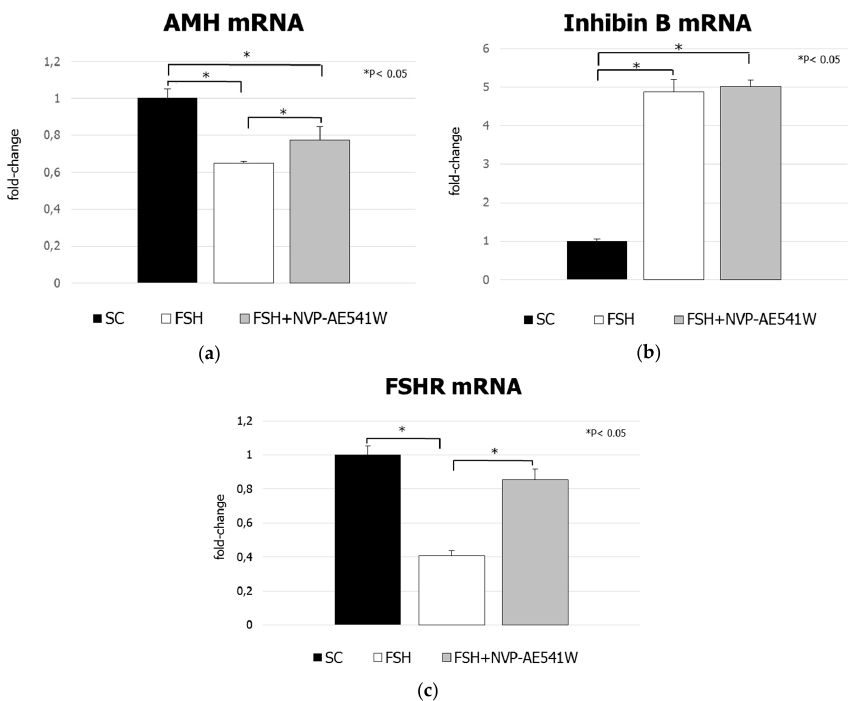
Figure 4. IGF1R does not influence the FSH-induced JNK (Thr18/Tyr185, Thr221/Tyr223) dephosphorylation. ( a ) Immunoblots and ( b ) densitometric analysis of the protein bands of pJNK, JNK and GADPH from SCs alone (control), or incubated with hpFSH alone or pre-treated with the IGF1R inhibitor NVP-AEW541 and/or PP1ß inhibitor tautomycin and then incubated with hpFSH. Data represent the mean ± SEM (* p < 0.05 vs. control) (one-way ANOVA) of three independent experiments, each performed in triplicate.